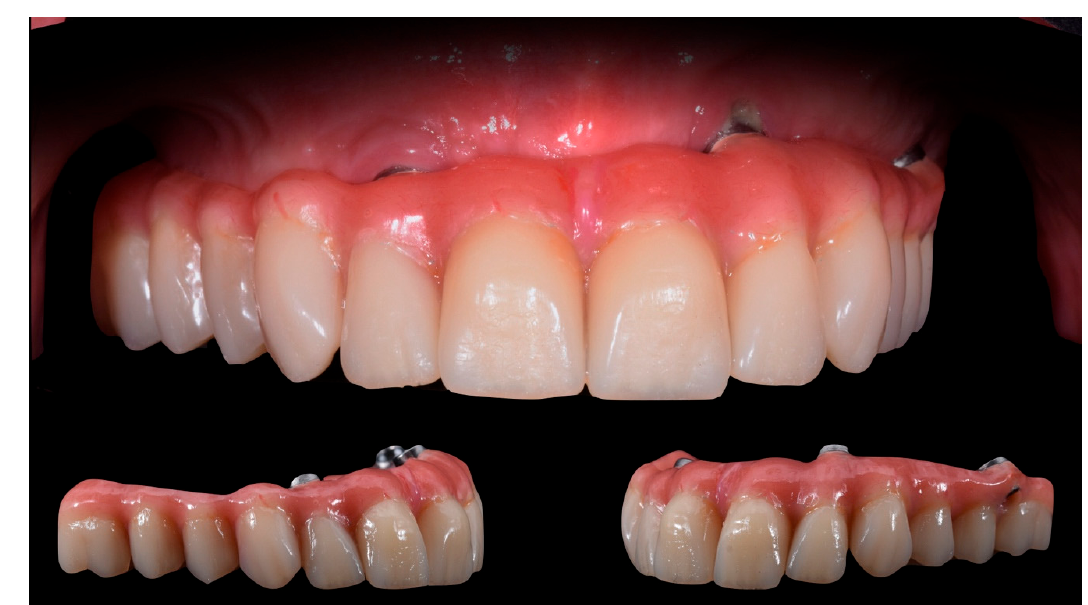
Figure 19. Final dental prosthesis view of the front, right and left side.